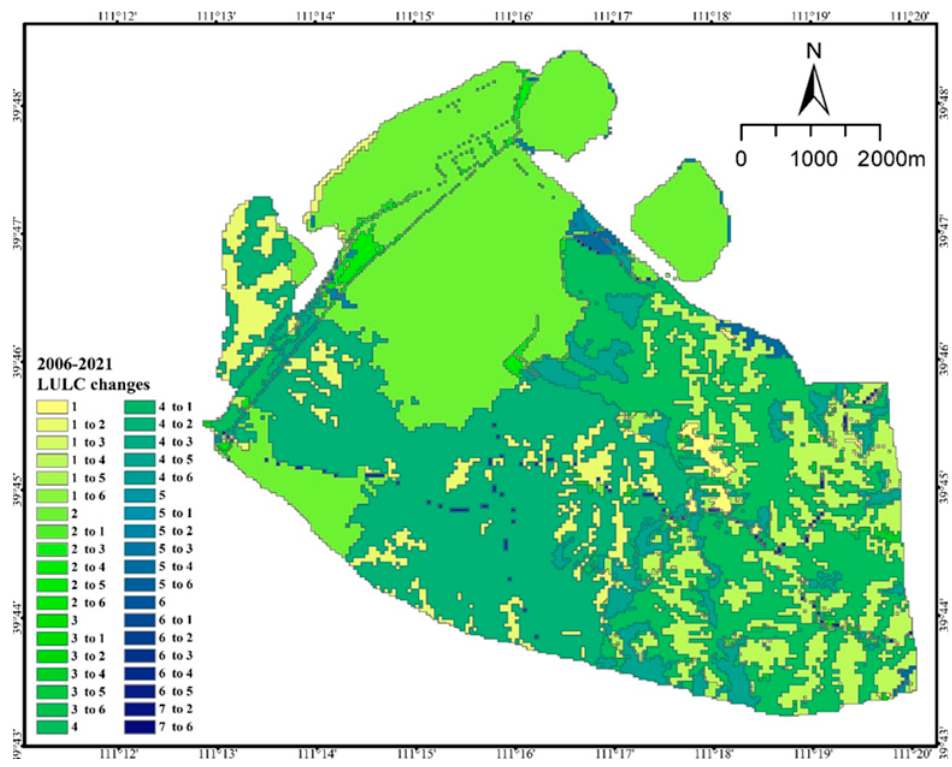
Figure 7. Land use/land cover type change for 2006 to 2021 (1. Cropland; 2. Industrial and mining land; 3. Forest; 4. Residential land; 5. Grassland; 6. Transportation land).